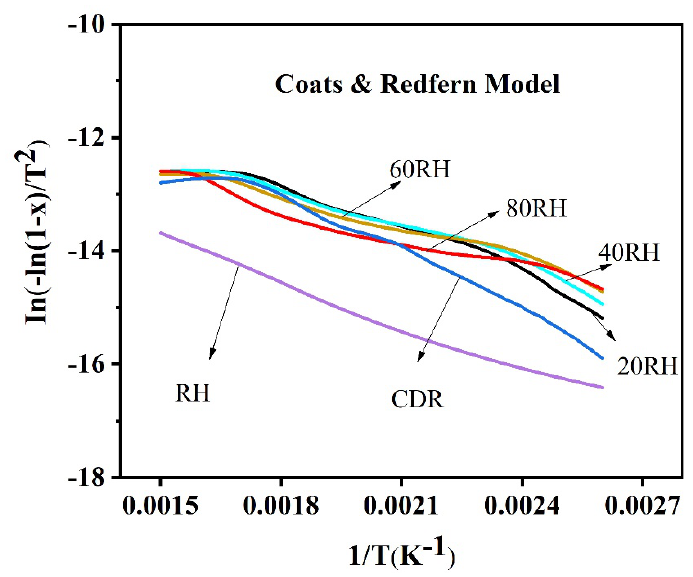
Figure 5. Plot of ln [ − ln(1 − x)/T 2 ] vs. 1/T for the pyrolysis process of RH/CDR blends. Table 4. Kinetic parameters for the pyrolysis of RH, CDR and their